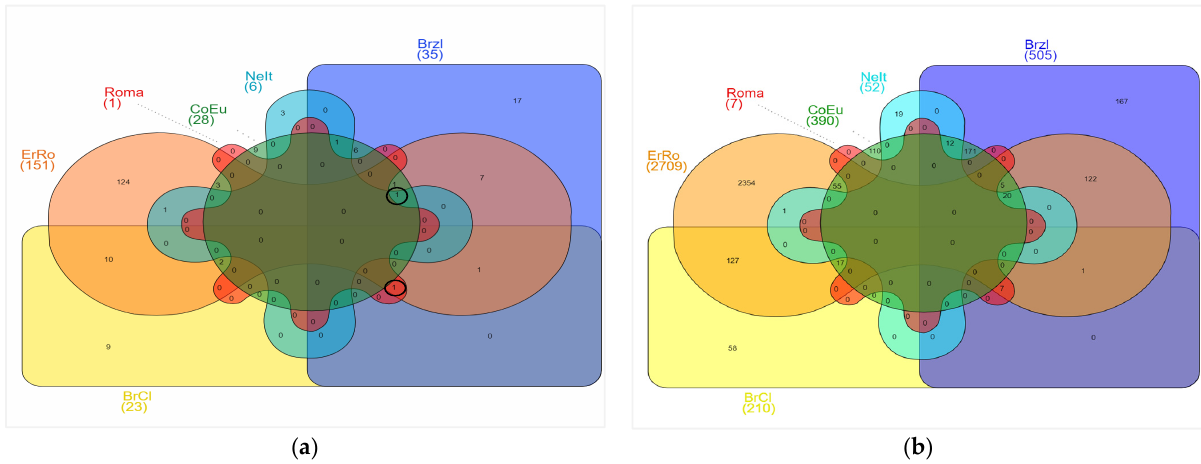
Figure 5. Venn diagram of proper (specific of one breed) and common ROH_islands (shared by at least two breeds) ( A ) and annotated genes ( B ). Circled frequencies of common ROH_island regions are those shared by four breeds.